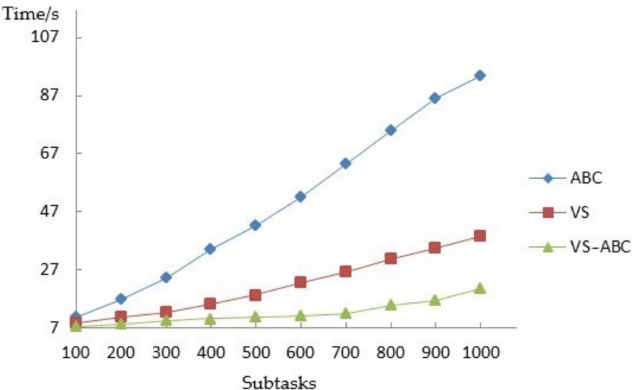
Figure 10. The trend of three algorithms’ running time ( J = 400, n =